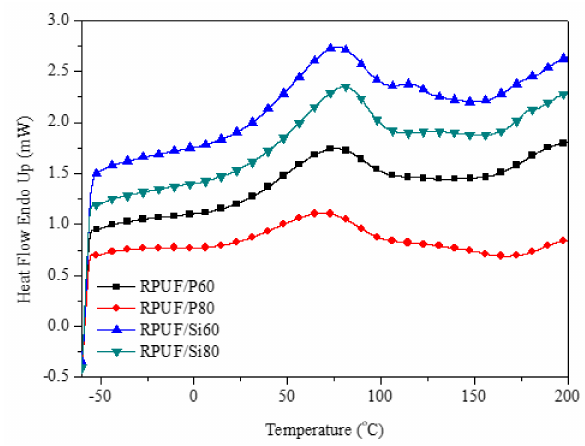
Figure 9. Differential Scanning Calorimetry (DSC) of